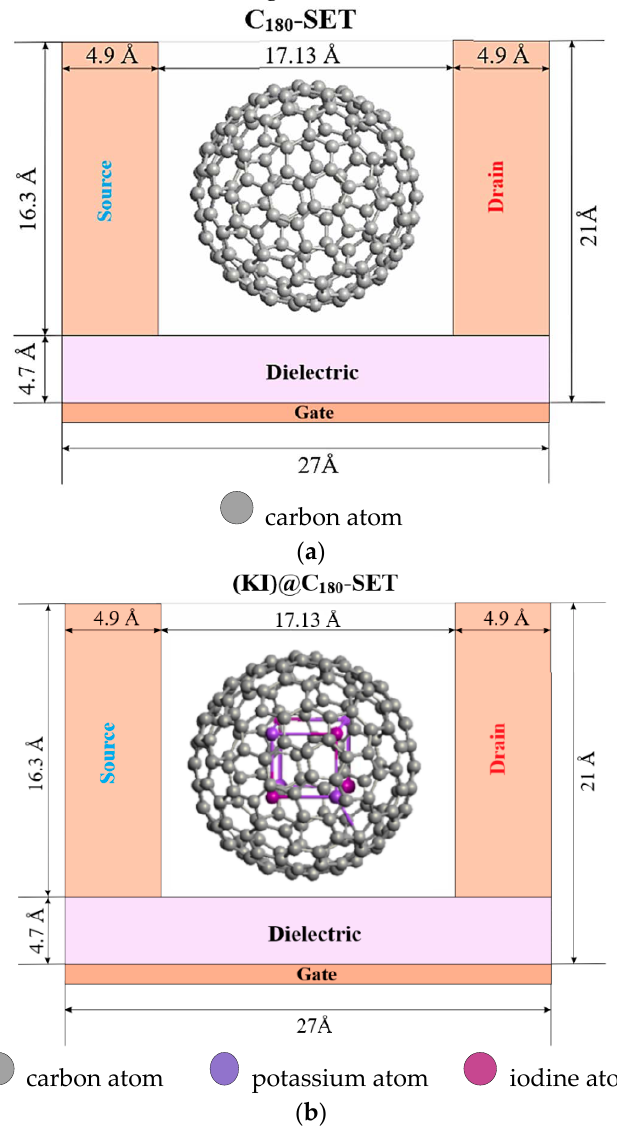
Figure 1. SET geometry: ( а ) C 180 -SET; ( b ) (KI)@C 180 -SET.